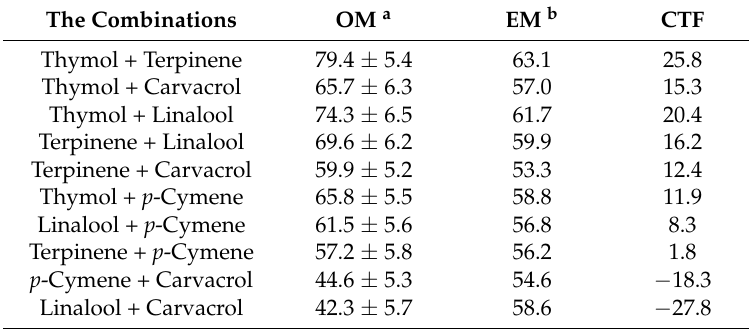
Table 3. Synergistic effect of binary mixtures of five different acaricidal compounds in thyme oil. The Combinations